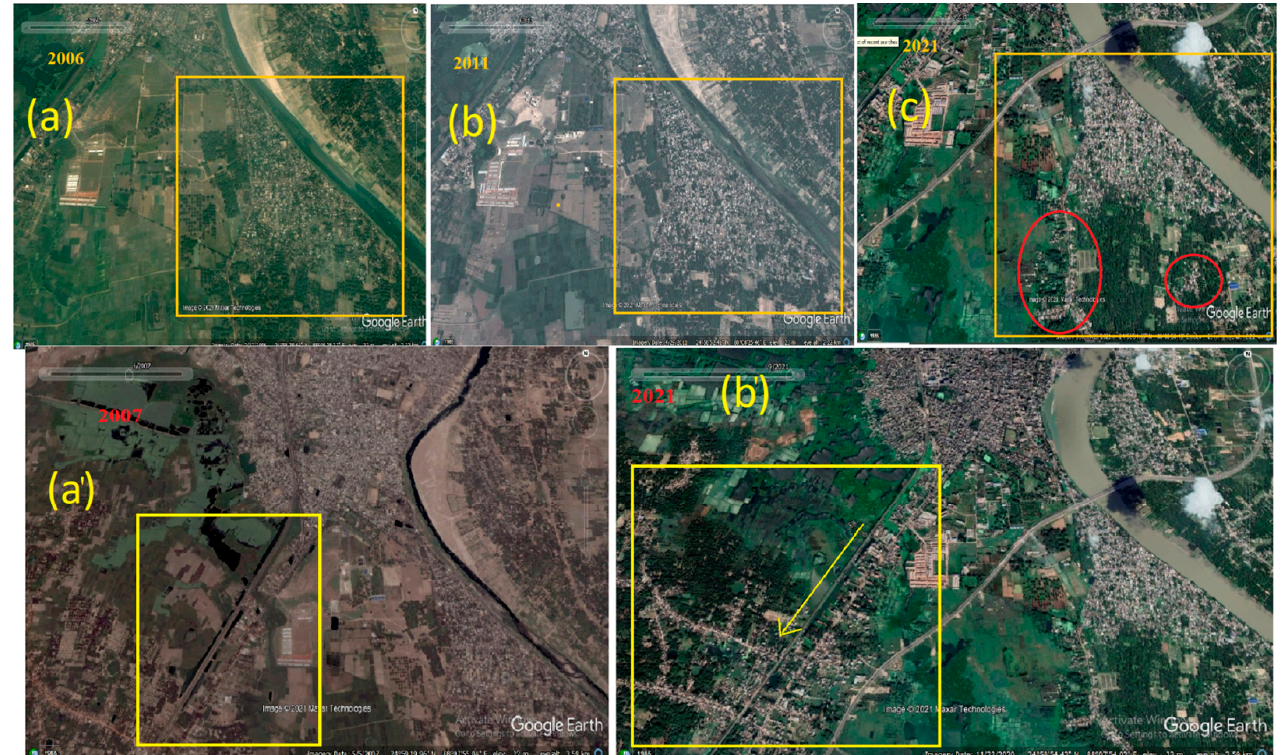
Figure 11. Present scenario of the urban landscape in the English Bazar block based on high-resolution satellite images (QuickBird, resolution 1 m) from Google Earth. ( a )–( c ) in upper part of figure shows South-eastern built-up expansion during 2006, 2014, and 2021, away from the municipal area. ( a’ , b’ ) in lower part of figure shows South-west built-up growth besides NH-34 during 2007–2021). As previously stated, a significant changing pattern was observed in the southern part of the study area, with water bodies in that area changing over time from 2001 to 2011. Some of it was converted into agricultural land, but from 2011 to 2021, the water bodies area increased again for the reasons previously stated. As a result, the Google Earth images clearly indicate that the water bodies are changing into built-up lands.